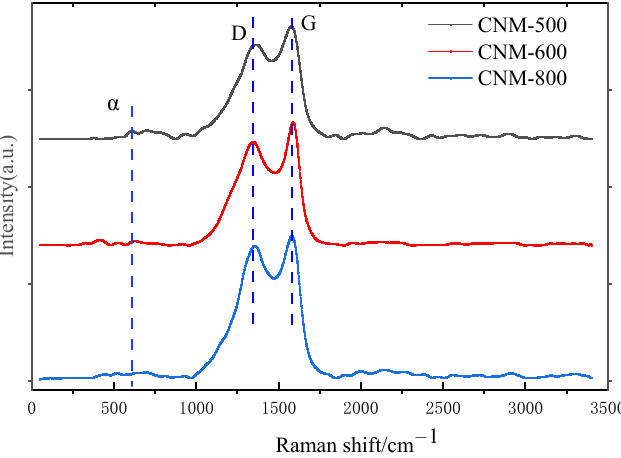
Figure 7. Raman spectra of carbon nanostructures at different temperatures.